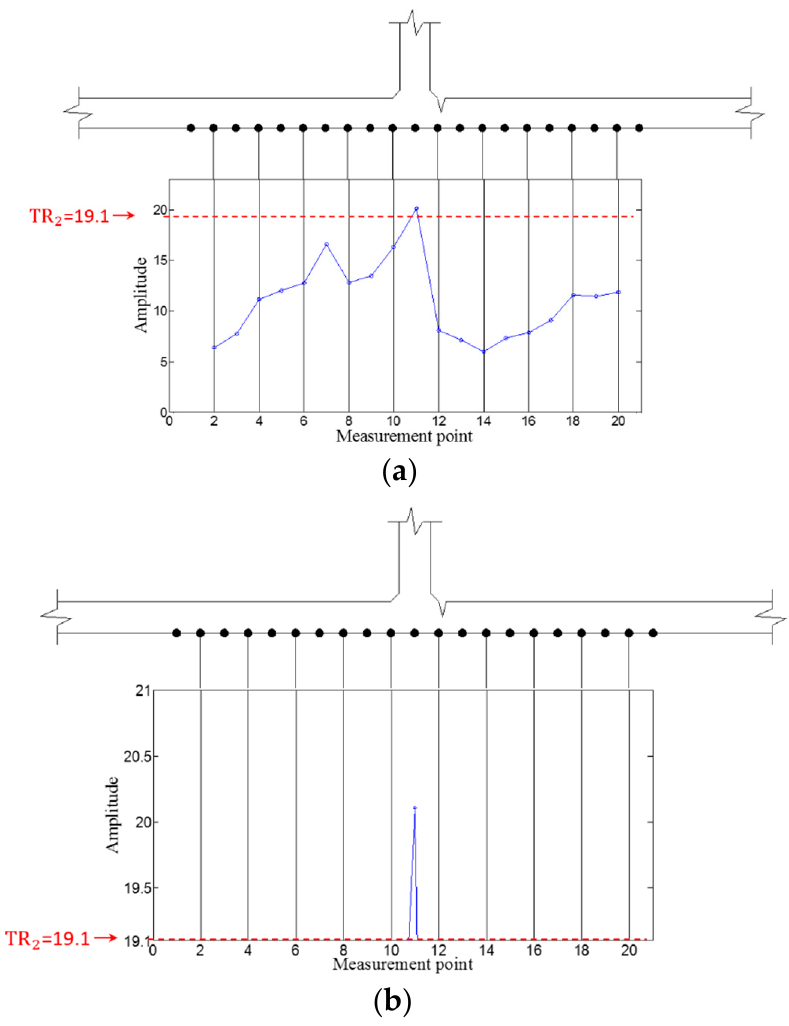
Figure 17. ZLCC values obtained from the crack area at 100 kHz ( a ) before and ( b ) after applying TR 2 .